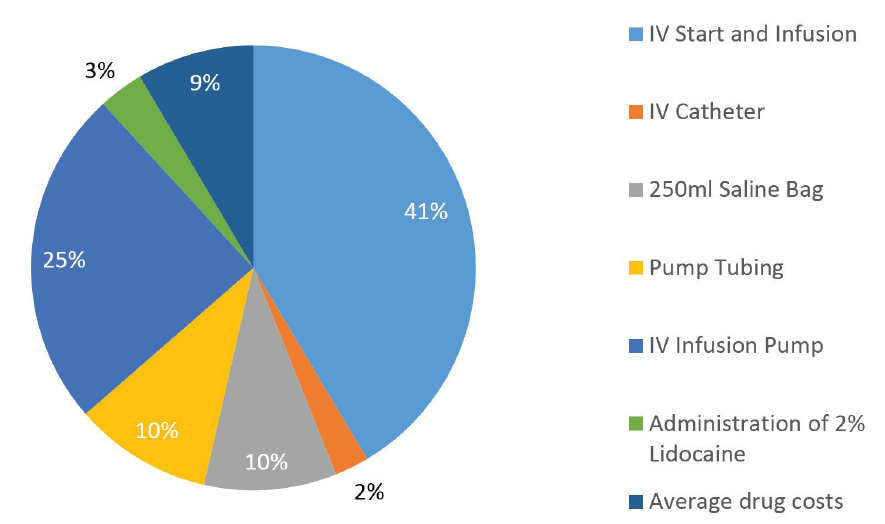
Figure 1. Contribution of the Components to the Overall Costs, assuming Administration of 2 IV